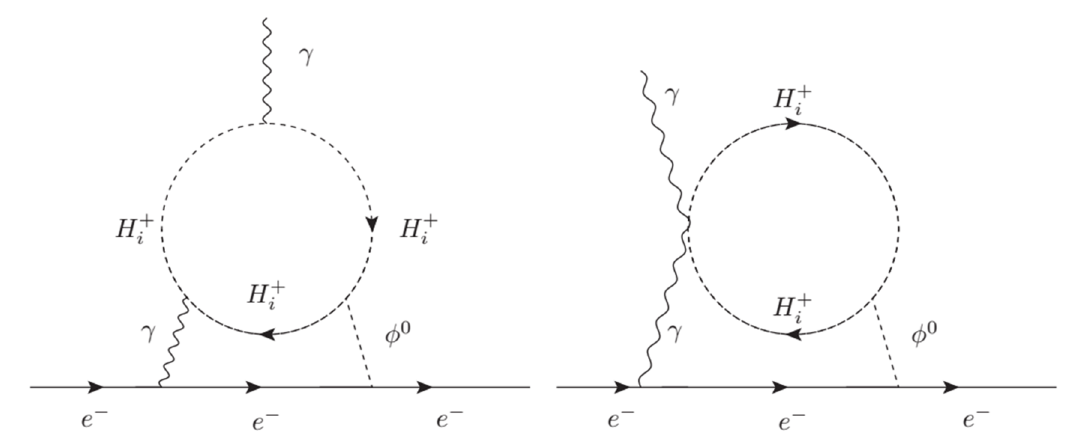
Figure 7 . Two of the Barr-Zee type diagrams for the eEDM involving a charged Higgs boson in the loop. These do not contribute in the 3HDM when CP violation is turned off in the neutral Higgs sector, as we assume in this